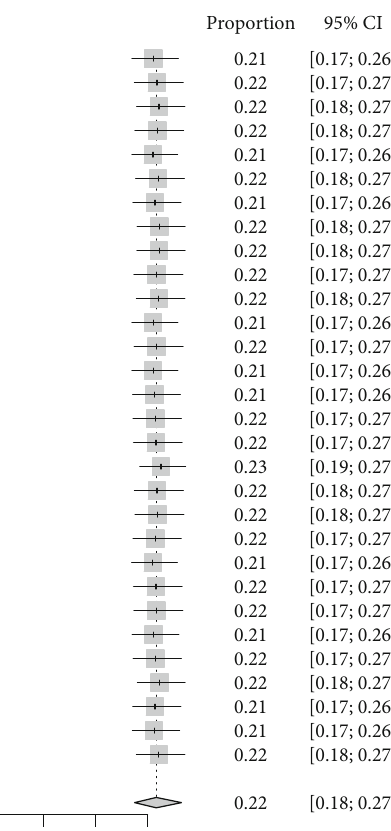
Figure 4: k − 1 leave-one-out sensitivity